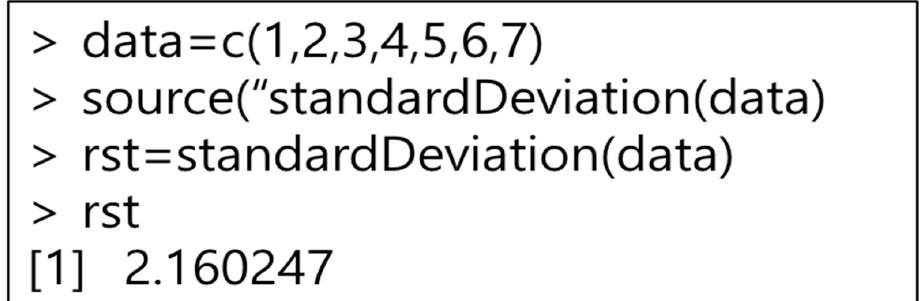
Figure 10. R function execution command.